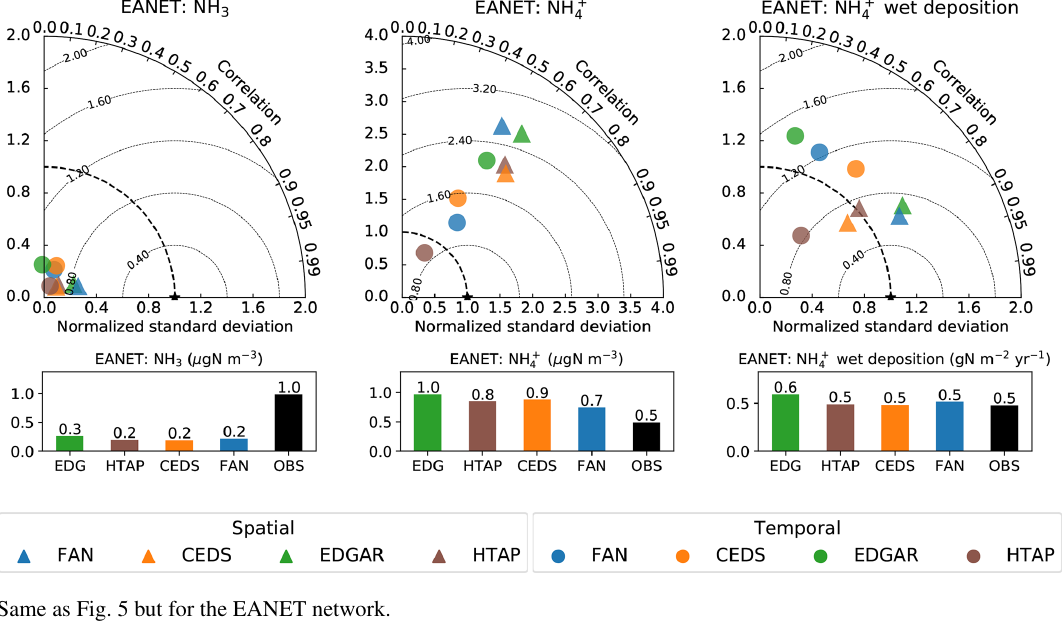
Figure 7. Same as Fig. 5 but for the EANET network.